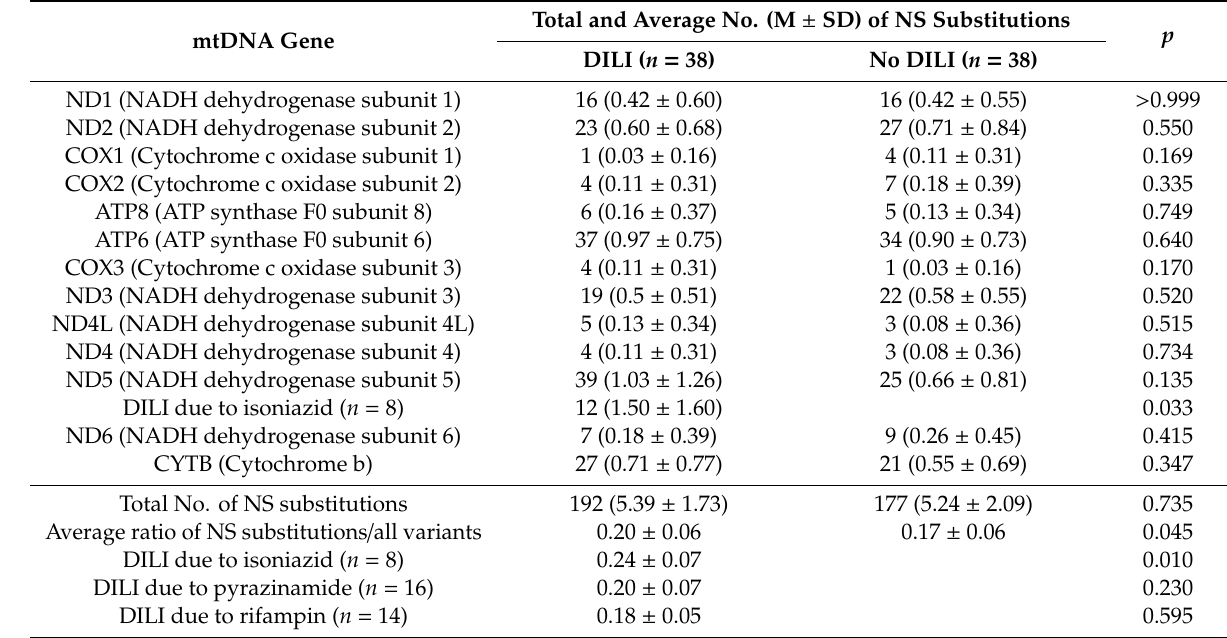
Table 3. Total and average number of nonsynonymous substitutions in mtDNA genes in TB patients with and without